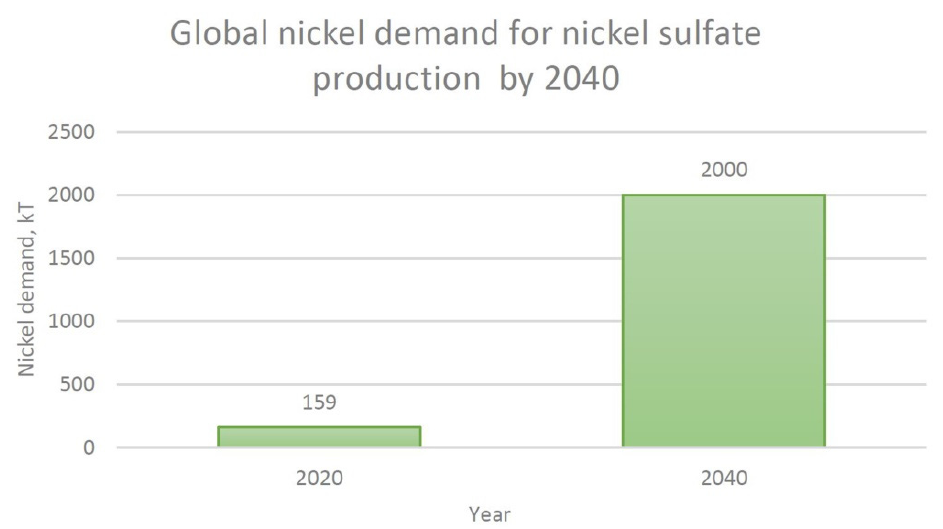
Figure 2. Forecast of the global nickel demand for nickel sulfate production by 2040 [5].